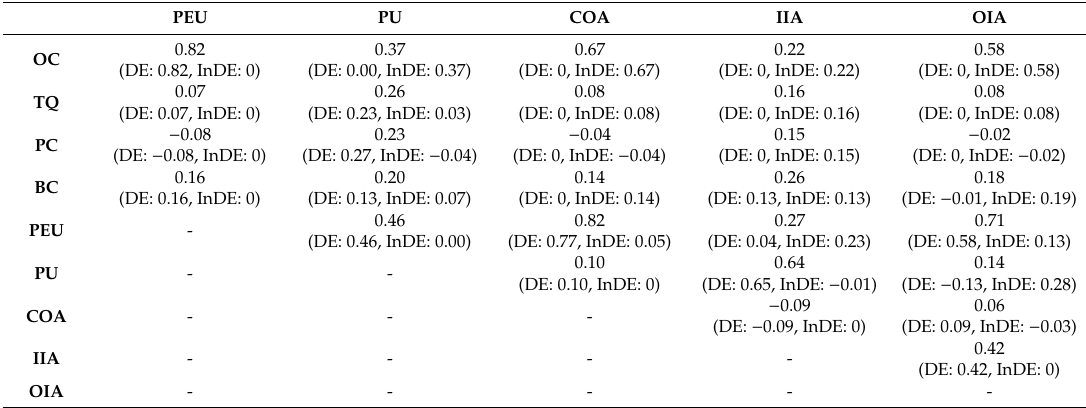
Table 6. The total e ff ects between